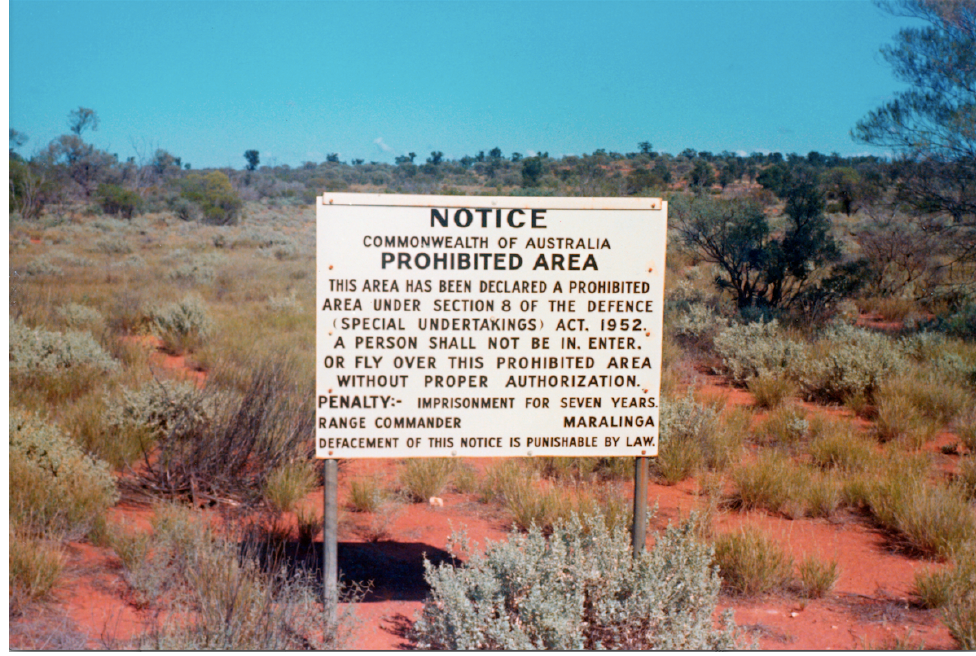
A signposted notice (in a language unintelligible to Aboriginal nomads) warns of seven years imprisonment for trespassing the bounds of the Maralinga nuclear test site at the Woomera Prohibited Area in South Australia. [source: Australian National Archive, Series: A6457 (“Photographs relating to atomic tests”),